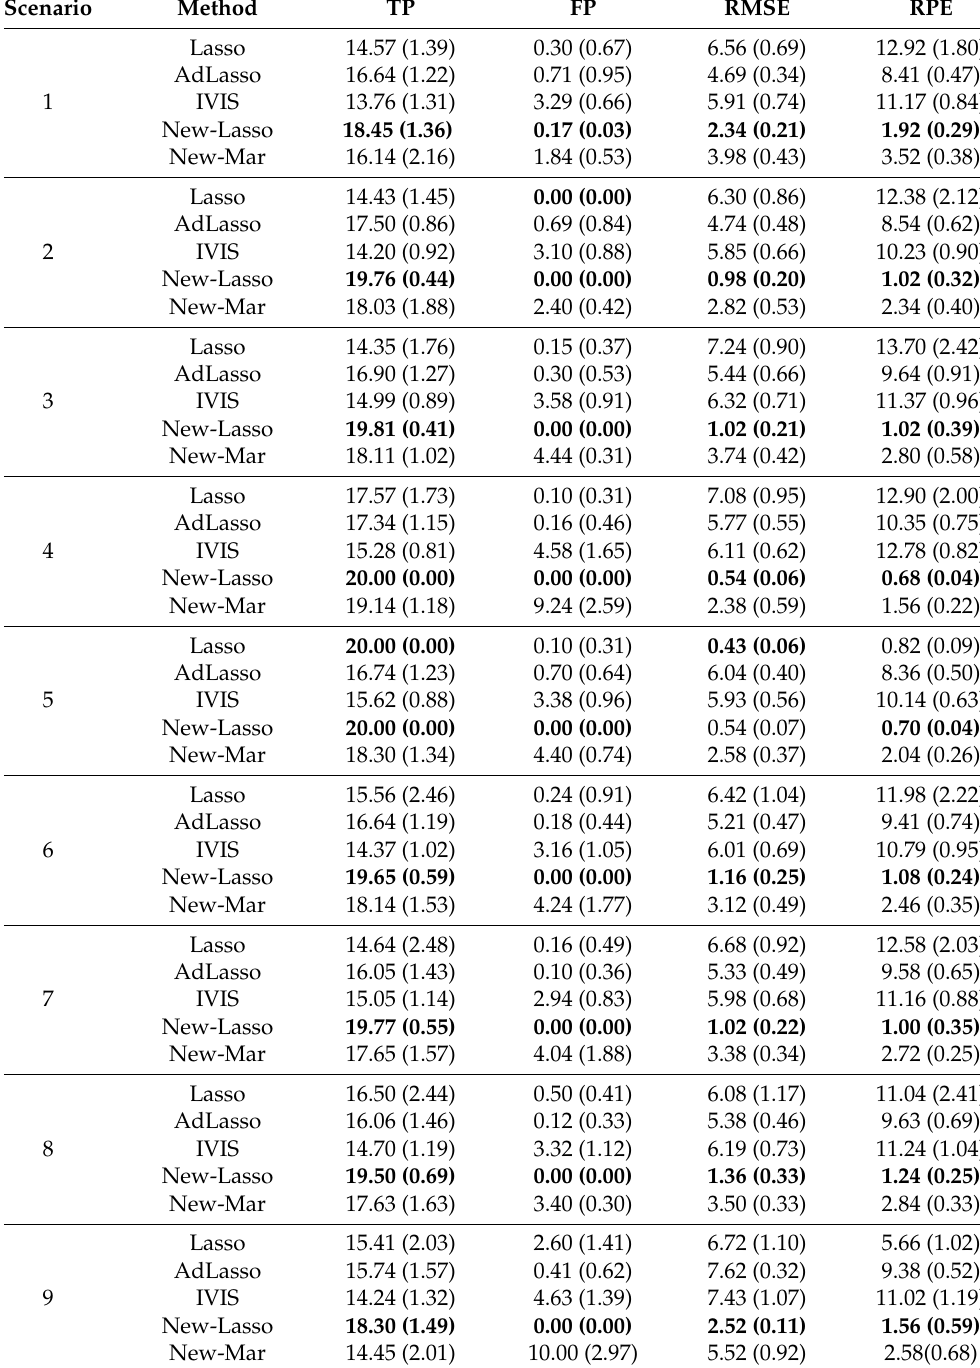
Table 1. Simulation results for N = 200, p = 500, q = 20, and ρ = 0.3. Each cell shows the mean (sd). The bold represents the best